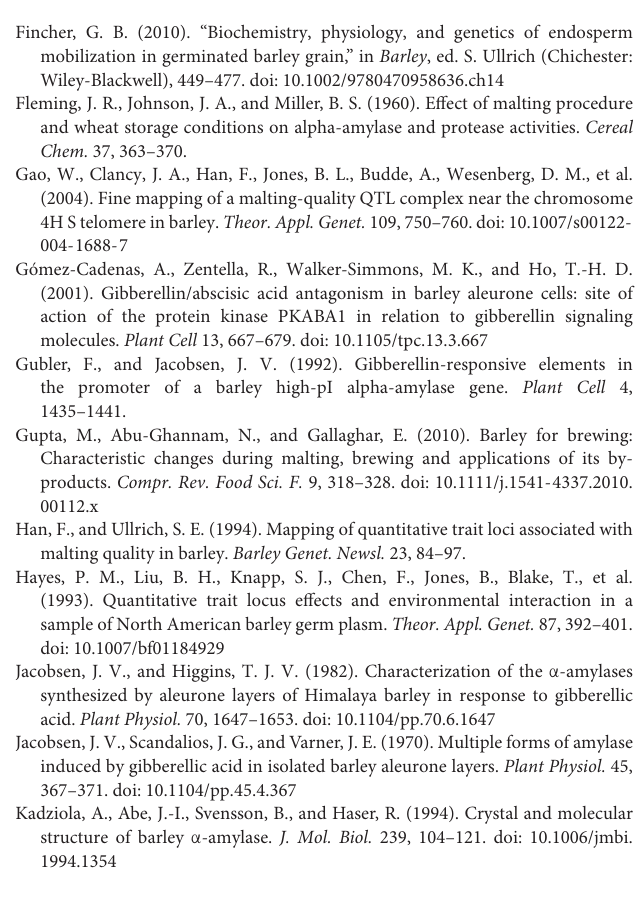
FIGURE S2 | Rice amy1 and amy2 promoter alignments. (A) ALL amy1 contain a GA-responsive element (GARE) TAACAAA (red box), a pyrimidine box (CCTTTT) and a TATCCA(C/T) box (blue boxes). (B) Rice amy2 promoter (LOC_Os06g49970) within 500 bp from translation start codon (ATG) contained GA-responsive element only. No pyrimidine and TATCCA(C/T) were found. FIGURE S3 | Alignment of wheat amy1 proteins. Wheat amy1 proteins were aligned using ClustalW software (http://www.genome.jp/tools-bin/clustalw). FIGURE S4 | Alignment of wheat amy2 proteins. Wheat amy2 proteins were aligned using ClustalW software (http://www.genome.jp/tools-bin/clustalw). FIGURE S5 | Alignment of wheat amy1 promoter sequences. ALL wheat amy1 contain a GA-responsive element (GARE) TAACAAA (red box), a pyrimidine box (CCTTTT), a TATCCA(C/T) box (blue boxes) and a cAMP-like motif (TGAGCTC) (green box). FIGURE S6 | Alignment of wheat amy2 promoter sequences. The GA-responsive element (GARE) TAACAAA (red), pyrimidine box (CCTTTT), TATCCA(C/T) box (blue), and OS2 motifs (green) are marked. FIGURE S7 | A comparison of new and old amy nomenclatures. The phylogenetic tree was generated using the ClustalW program (http://www.genome.jp/tools-bin/ clustalw). The nucleotide sequences were collected from GenBank with accession numbers M17125.1, M17126.1, M17127.1, and M17128.1 (Knox et al., 1987); X15226 and X15227 (Rahmatullah et al., 1989); J01236.1 (Rogers and Milliman, 1983); K02637 (Rogers, 1985); J04202 (Khursheed and Rogers, 1988), and X05166 (Whittier et al.,